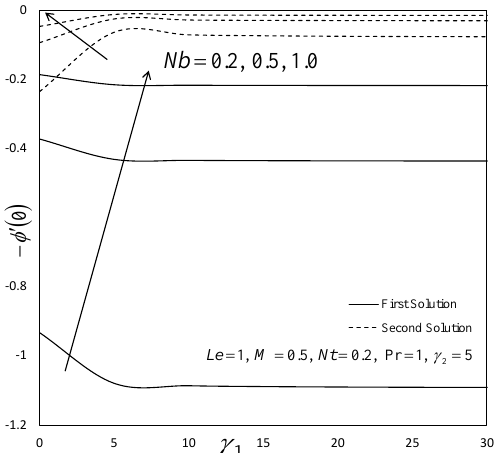
Figure 15. Variations of − φ (cid:48) ( 0 ) towards γ 1 for selected values of Nb .